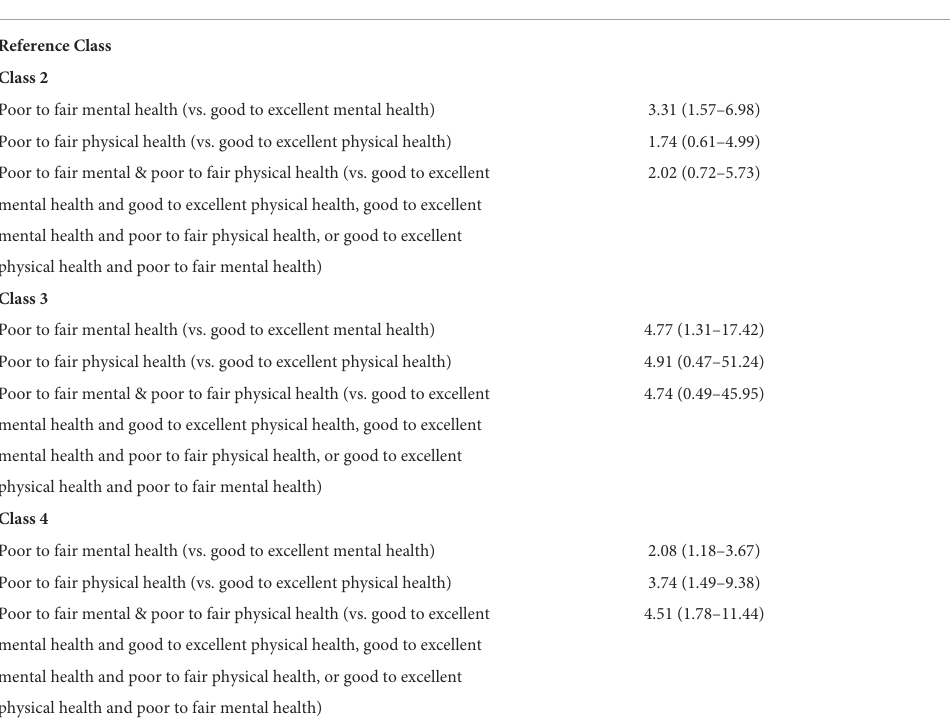
TABLE 4 Associations between latent classes and self-rated mental and physical health. Class 1 Class 2 Class 3 High probabilities of PCT Low-medium probabilities of PCT Medium probability of PHD Low probability of PHD High probability of